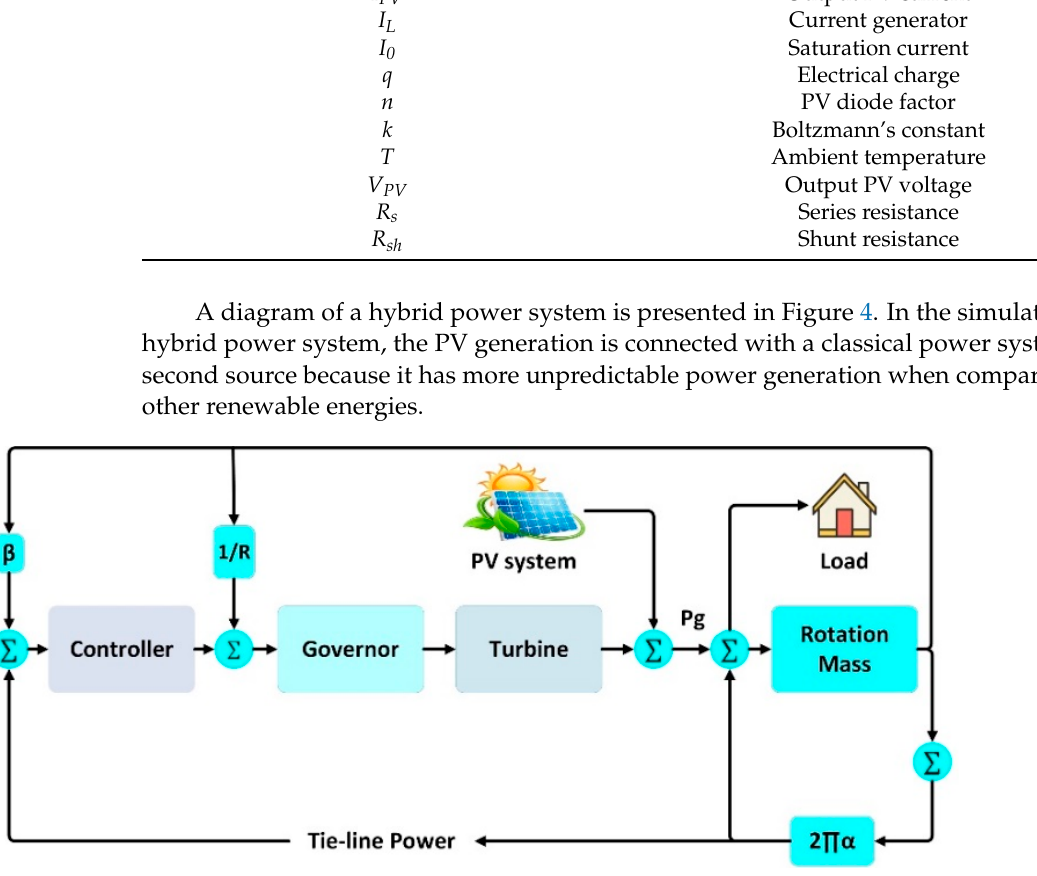
Figure 4. Diagram of a hybrid power system.